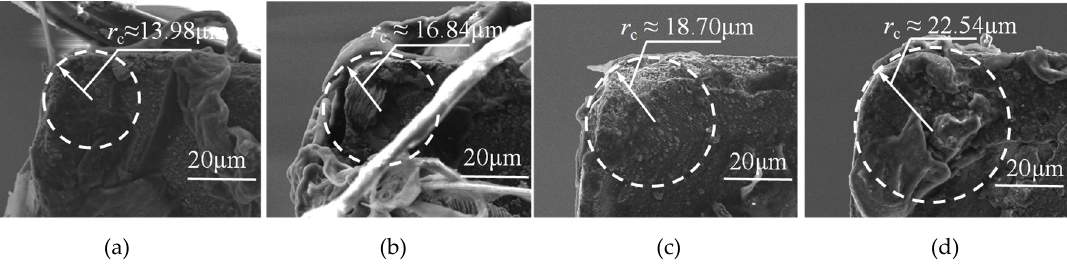
Figure 5. The measurement of the corner radius after a cutting distance of 300 mm. ( a ) Corner 1 for BMG; ( b ) corner 2 for BMG; ( c ) corner 1 for Al6061; ( d ) corner 2 for Al6061.